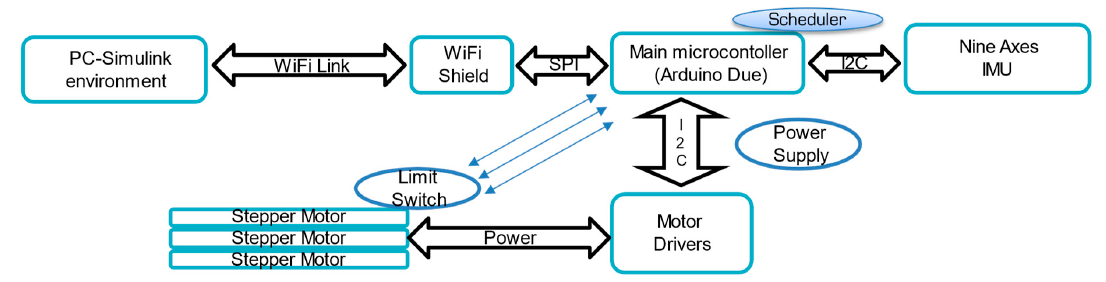
Figure 6. Architectural diagram of the automatic balancing system.